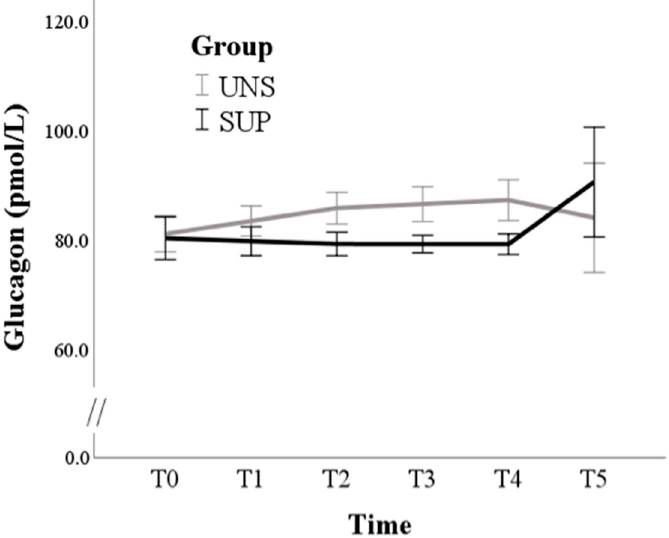
Figure 4. Means and standard errors of glucagon plasma concentrations in control (UNS) and supplemented (SUP) lactating sheep monitored before the administration of supplementation (T0), and then every 10 days until dry off (T1–T5).